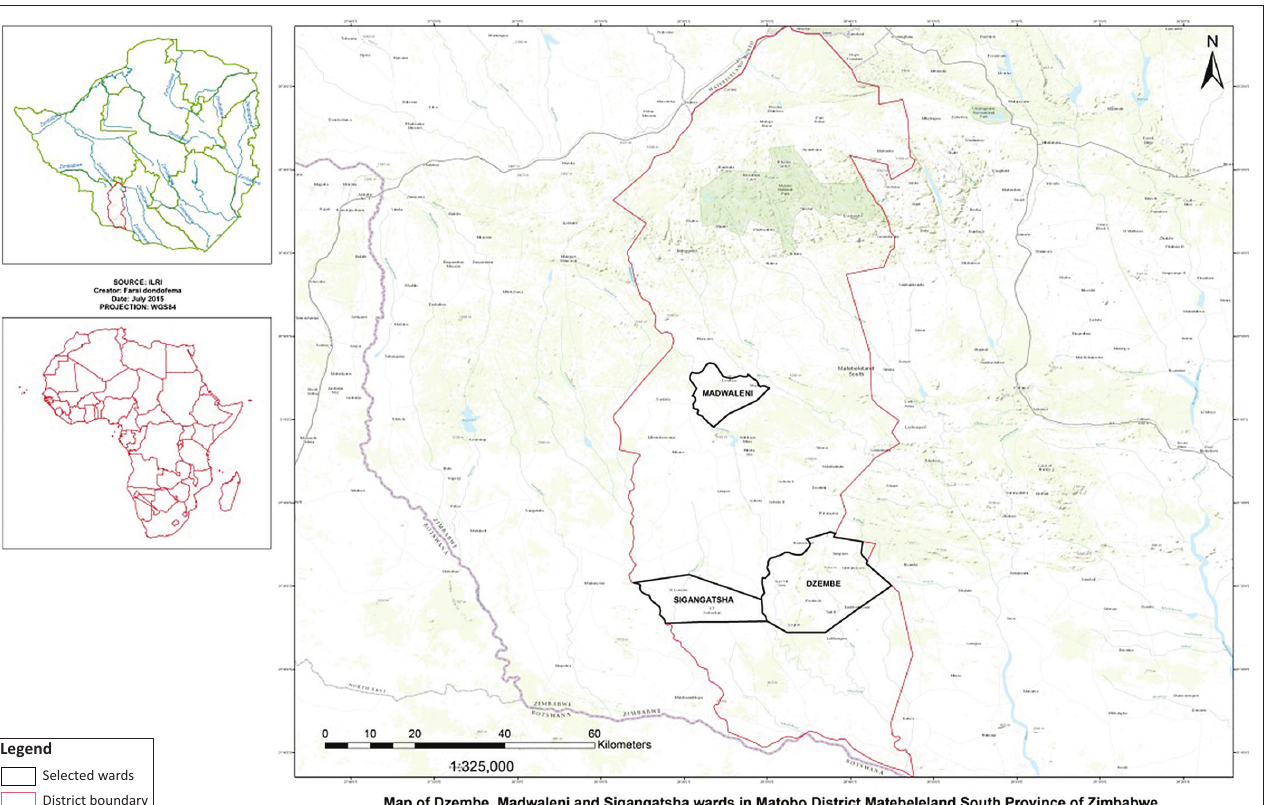
FIGURE 2: Selected study sites in Matobo District,